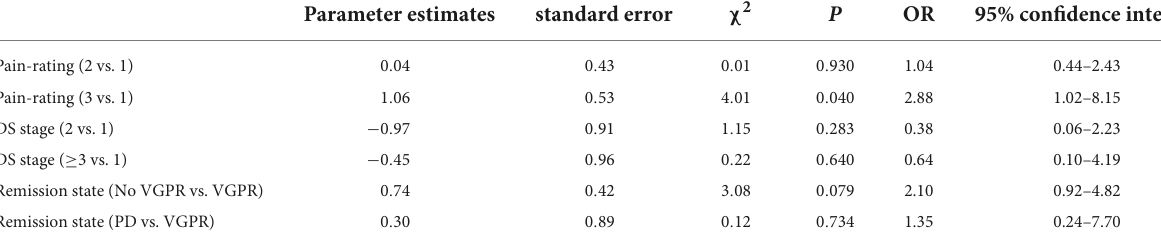
TABLE 5 Multiple logistic regression analysis of MM with anxiety ( n =